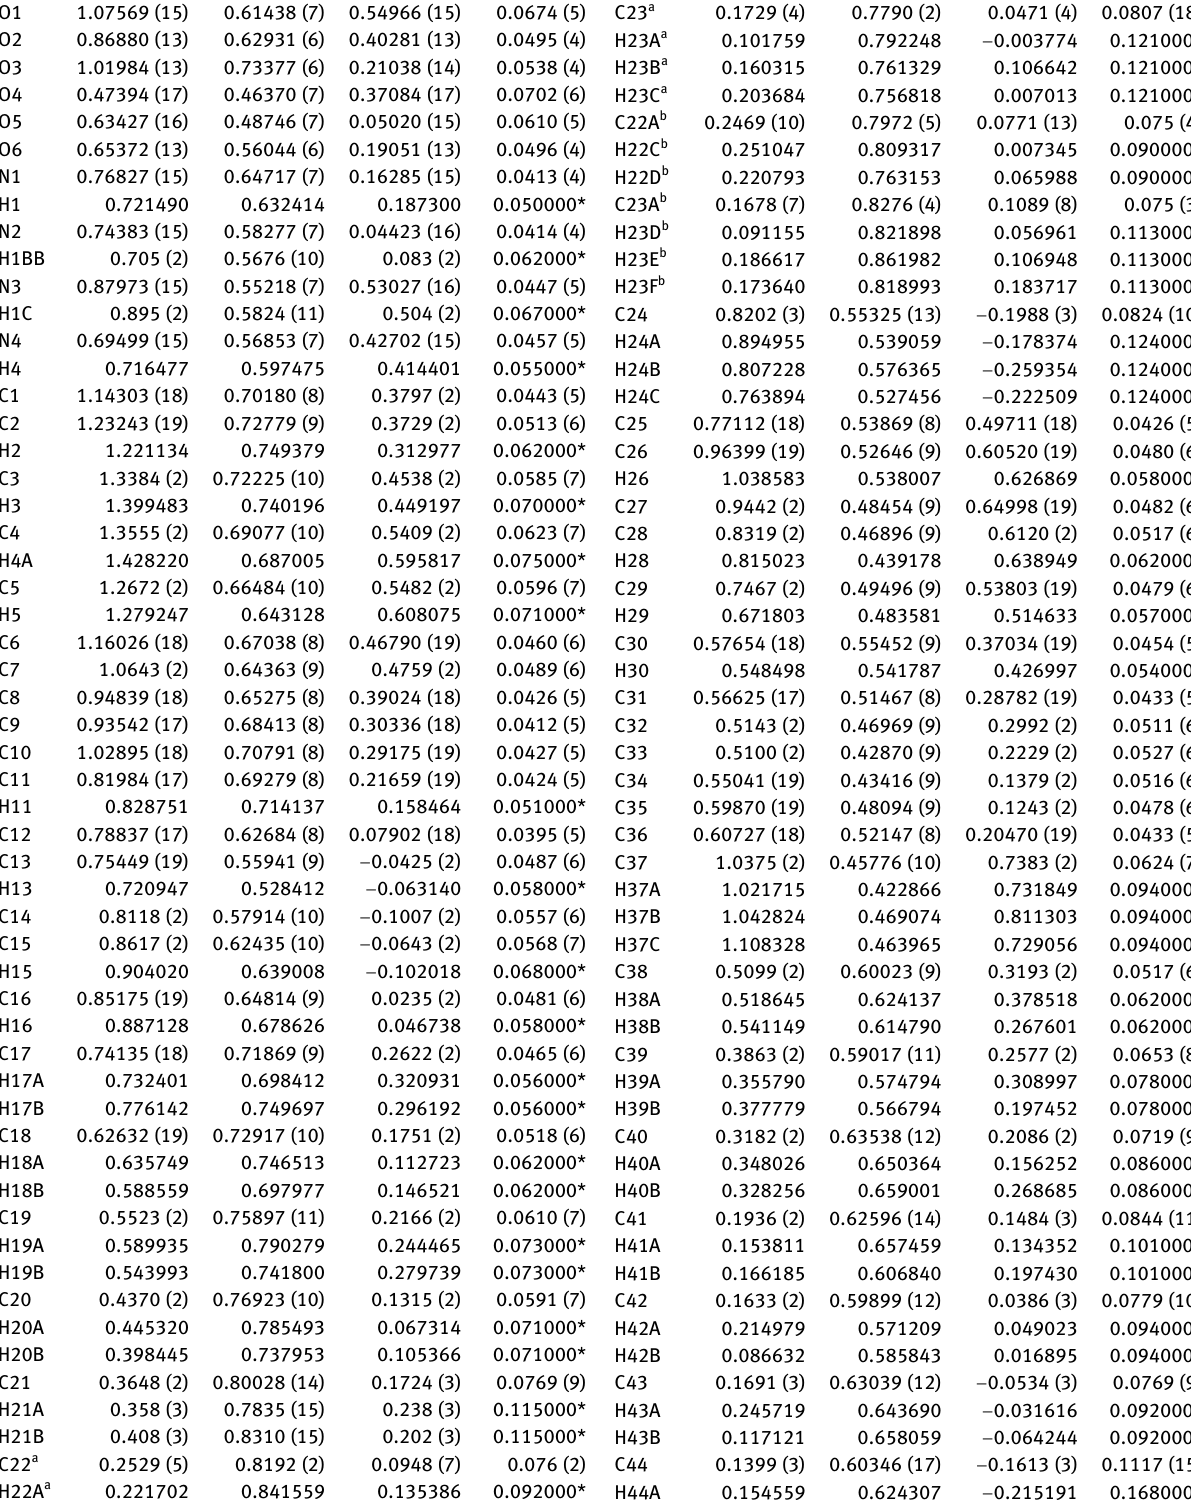
Table  : Fractional atomic coordinates and isotropic or equivalent isotropic displacement parameters (Å 